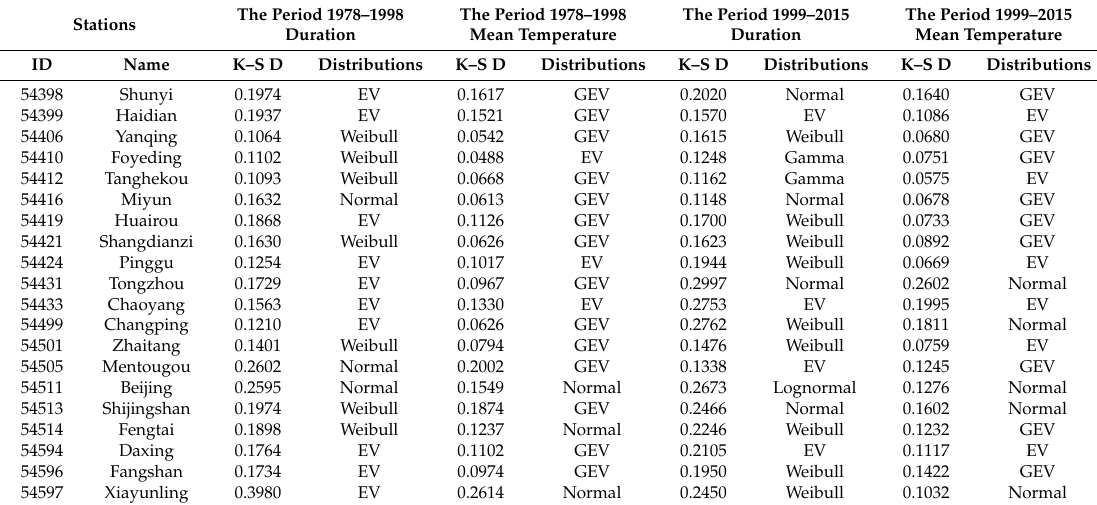
Table 7. The goodness-of-fit based on Kolmogorov-Smirnov (K–S) D statistics for duration and intensity of extreme low temperature events at 20 meteorological stations in Beijing